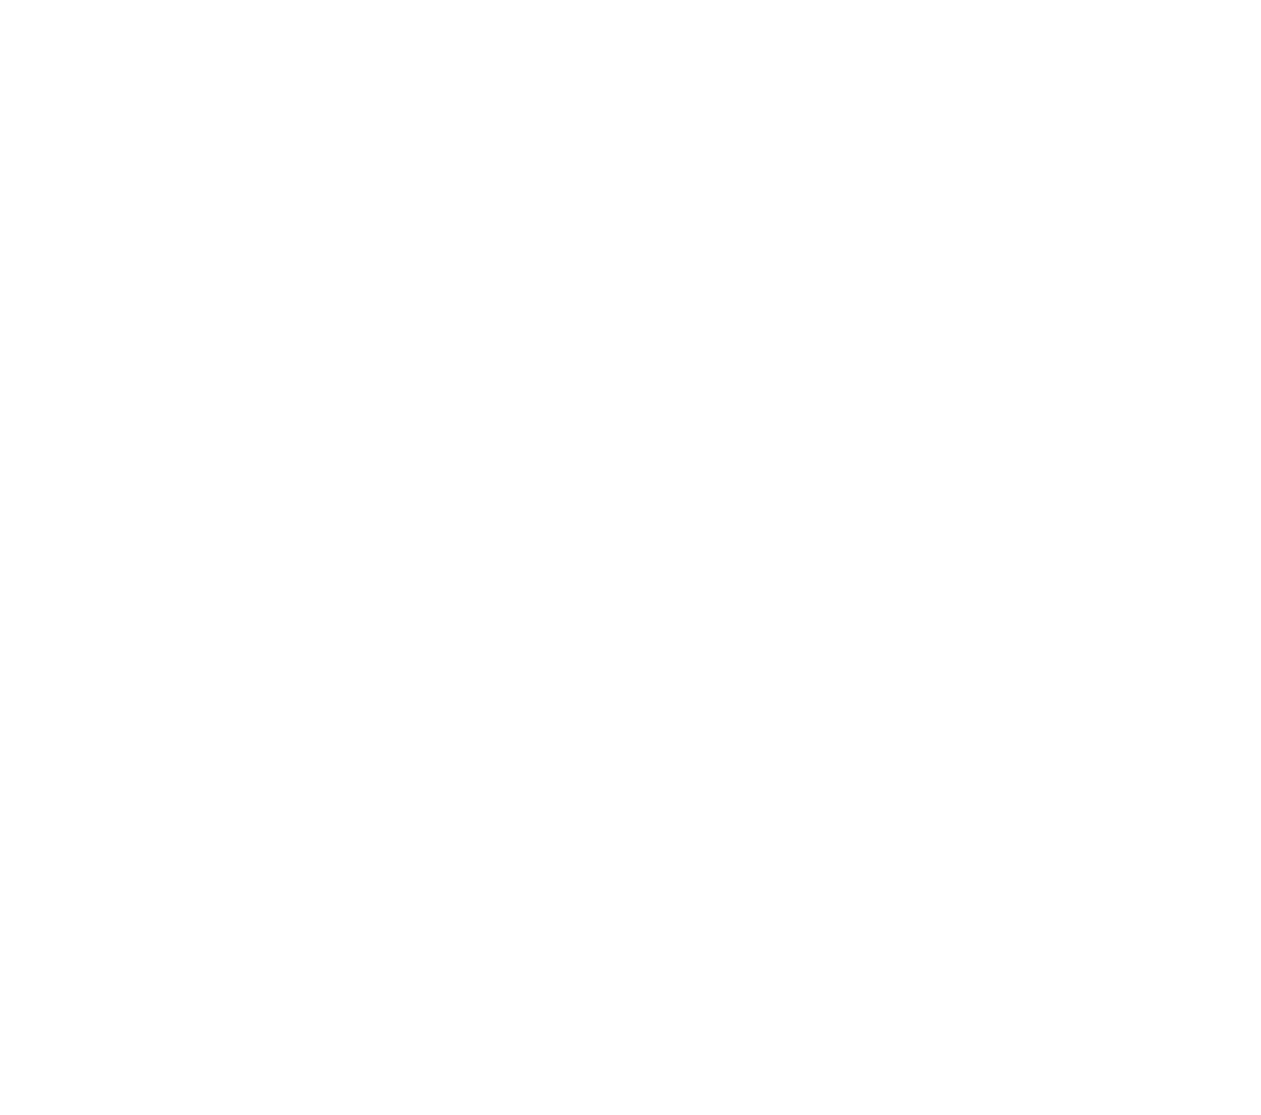
FIGUREA2 | Quantile plots for the evolution of low k -values during the formation of primary tumors. Proportion of the mass with [ (A) -left] k = 0, [ (B) -middle] k ≤ 0.033, and [ (C) -right] k ≤